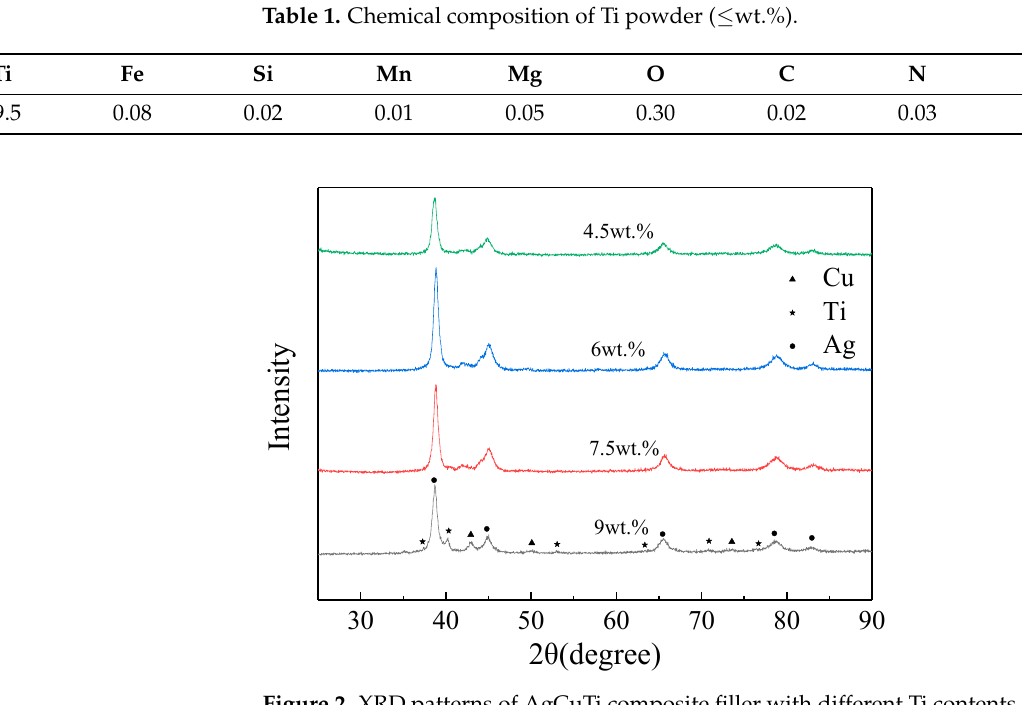
Figure 2. XRD patterns of AgCuTi composite filler with different Ti contents.